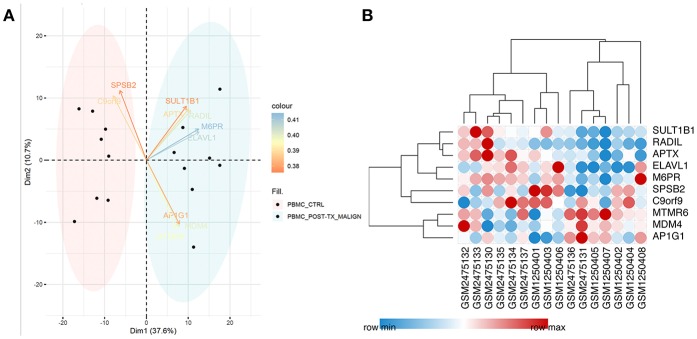
Identification of differentially expressed genes. (A) Using PCA methods, the top 10 DEGs were revealed according to the contributed scores between the CTRL-Tx group and post-Tx malignancy group. (B) The expression of the DEGs and Pearson correlation analysis.